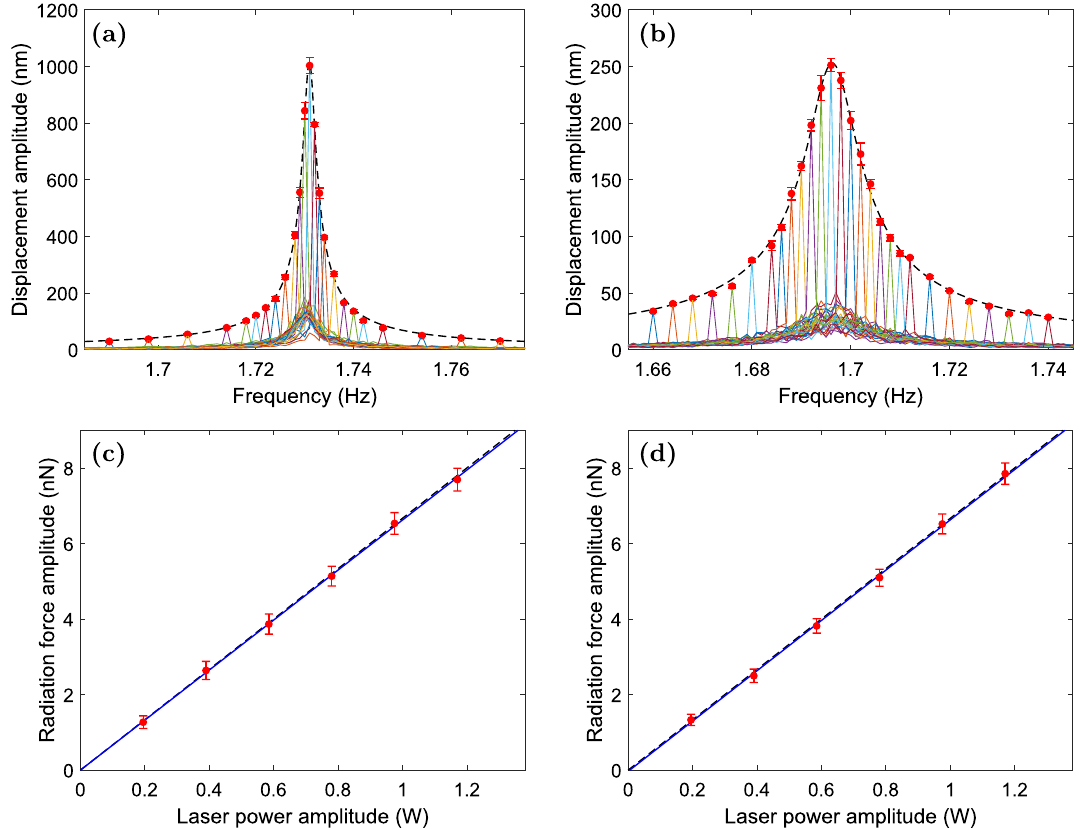
Figure 2. The measured displacement amplitude of the mechanical oscillator is plotted ( a ) for the lower damping oscillator and ( b ) for the higher damping oscillator as a function of the modulation frequency of the 0.975 W. Each graph that is marked with a driving laser with an example peak to peak power amplitude of P 0 = solid line is the averaged frequency spectrum of a measurement for a single modulation frequency. The graphs peak at the modulation frequency and the peak points are marked with red dots. The modulation frequency is varied around the resonance frequency of the mechanical harmonic oscillator. The peak points of the graphs form together a curve that is the response function of the mechanical harmonic oscillator. The fitted harmonic oscillator response function is marked with the dashed line. In ( c ) and ( d ), the measured peak to peak radiation force amplitude is plotted for the two oscillators as a function of the peak to peak laser power amplitude. 2 P 0 / c is The least-squares regression lines are marked with the solid lines. The linear theoretical curve F 0 = 0.5% uncertainty of the laser presented by the dashed lines. The horizontal error bars corresponding to the ± power are not shown because of their